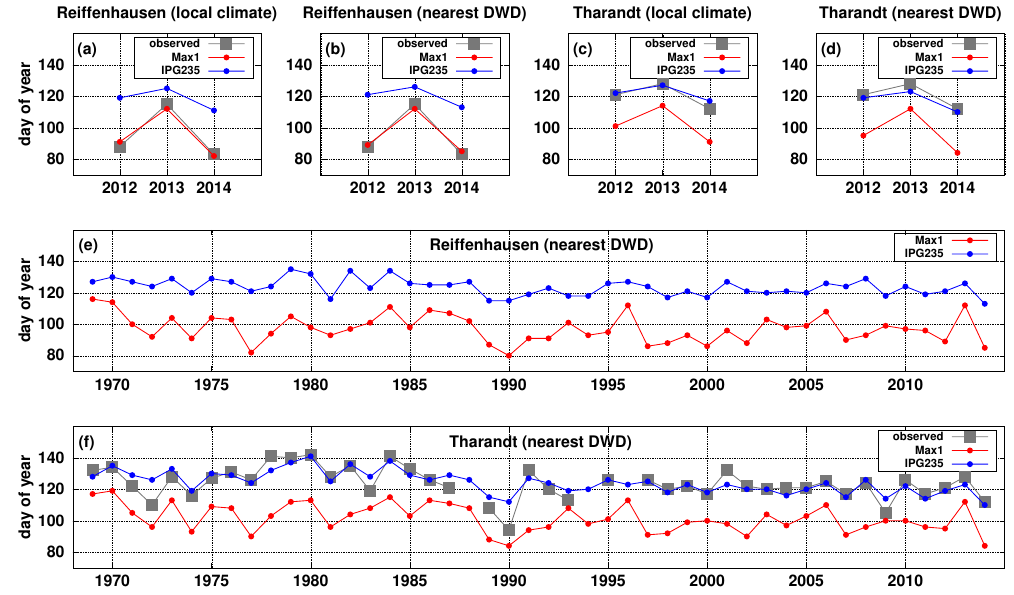
Figure 3. Estimated day of year (DOY) of leaf unfolding (LU) using the Max1 and IPG235 parameters for the site Reiffenhausen with local temperature measurements (a) and temperatures from the nearest DWD station Göttingen (b) for the years 2012 to 2014; same for Tharandt, local temperatures (c) and nearest climate station Wildacker (d) ; with observations. The lower subplots show long-term estimates for DOY of LU using the DWD temperatures for Reiffenhausen (e) and for Tharandt (f) , where also long-term observations are available. Table 3. Description of the eight performed model simulations. All model parameters are constant, except leaf area index (LAI), stomatal resistance (Rsc) and the date of leaf unfolding (LU) for the two parameter sets Max1 and